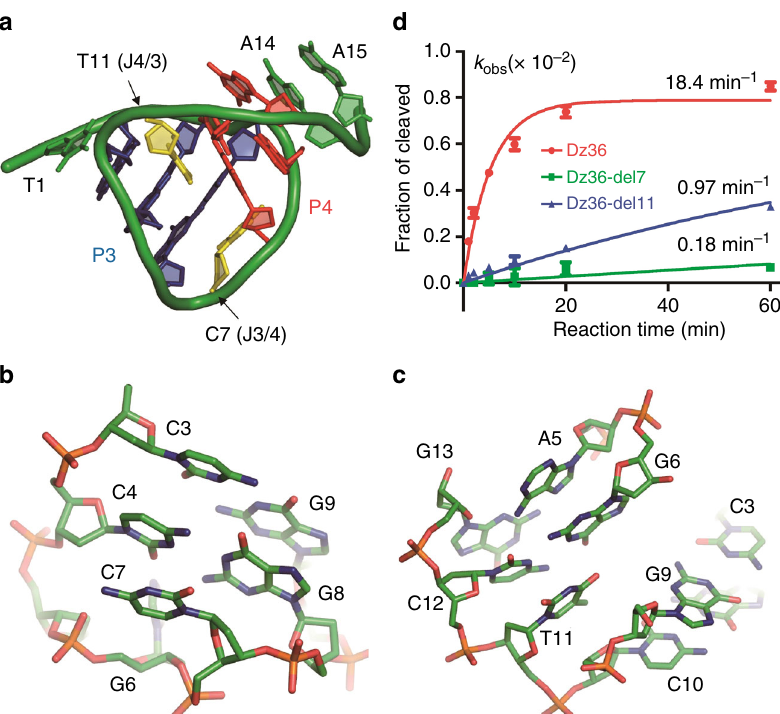
Fig. 4 Functional characterization of the bridging residues. a Cartoon representation showing the overall fold of the catalytic core. The base pairs of P3 and P4 are colored in blue and red, respectively. The bridging residues C7 and T11 are colored in yellow. Stick representation of b C7 at the bridging site J3/4 and c T11 at the J4/3 bridging site. d Comparison of the catalytic activities of the wild-type DNAzyme and mutants with C7 or T11